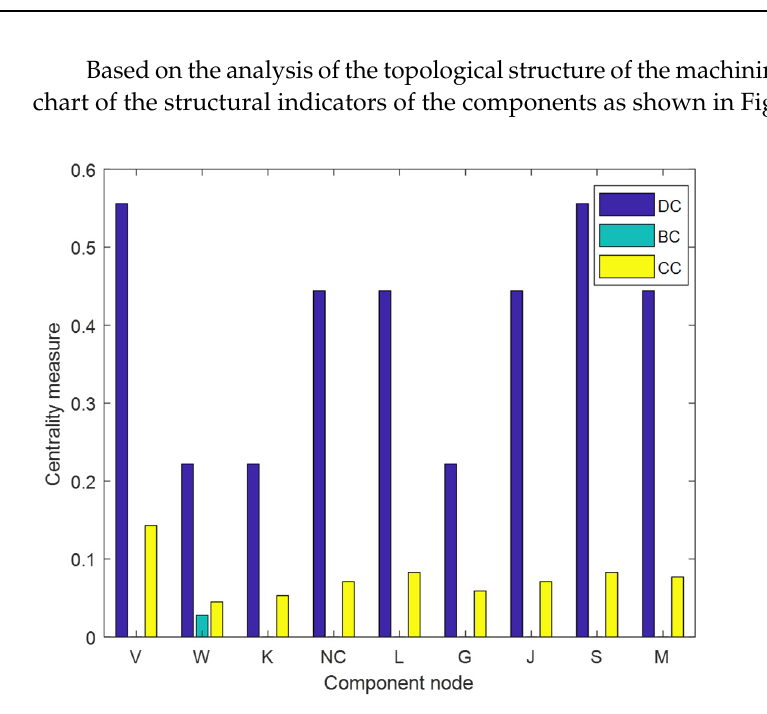
Figure 11. Comparison of structural indicators of machining center components.